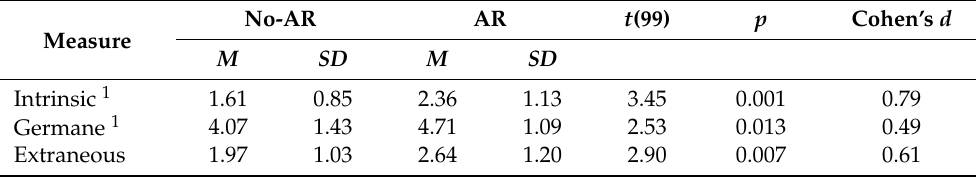
Table 5. Results of the t -tests for the different types of cognitive load in the second experiment (MP03).